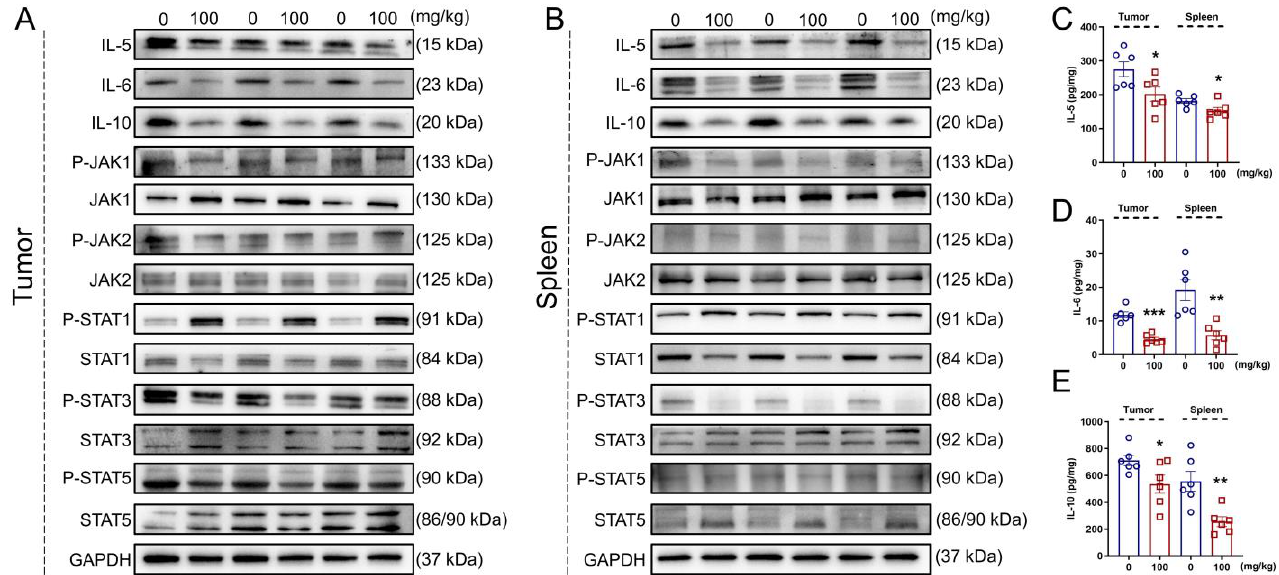
Figure 5. IHS inhibits JAK/STAT3/IL6 signaling in Apc Min/+ mice. IHS decreased the protein levels of IL-5, IL-6, IL-10, P-JAK1/JAK1, P-JAK2/JAK2, P-STAT3/STAT3, and P-STAT5/STAT5 and increased the level of P-STAT1/STAT1, as detected through Western blotting of tumor ( A ) and spleen tissue ( B ) of Apc Min/+ mice. IHS decreased the levels of ( C ) IL-5, ( D ) IL-6, and ( E ) IL-10 in tumor and spleen tissue of Apc Min/+ mice, as detecting through ELISA. Data were analyzed using a one-way ANOVA and are shown as means ± SEM. * p < 0.05, ** p < 0.01 and *** p < 0.001 vs . vehicle-treated group.